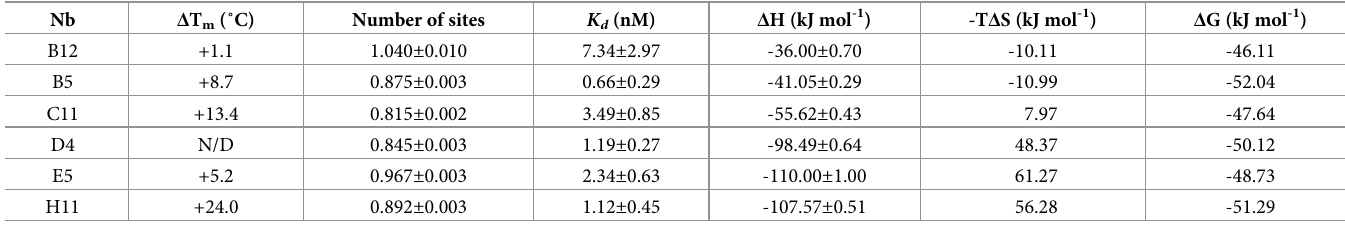
Table 1. Thermal stability and thermodynamics of Nb binding to